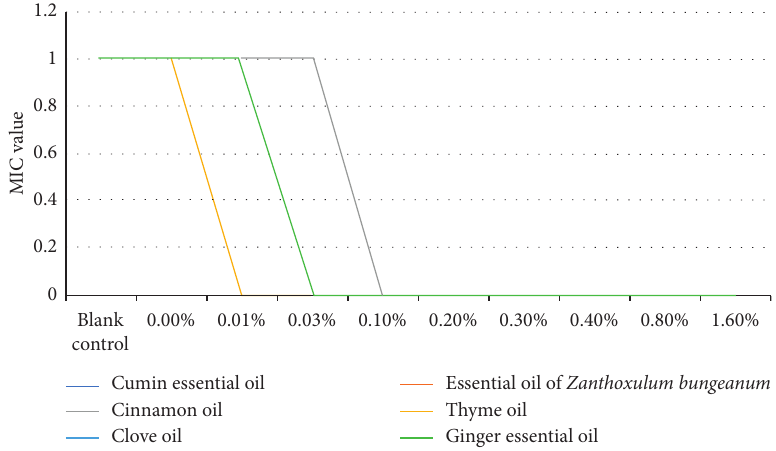
Figure 2: Minimum inhibitory concentration of six essential oils. Table 2: Orthogonal experiment table.